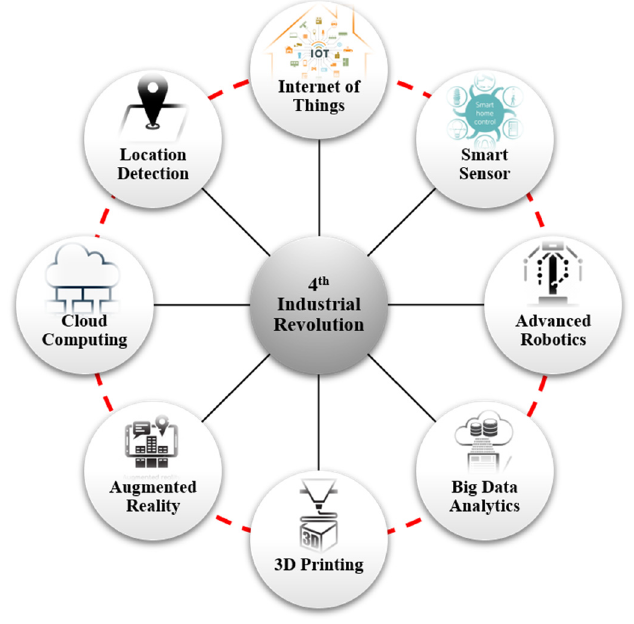
Figure 1. Various advanced technologies that constitute the fourth industrial revolution.